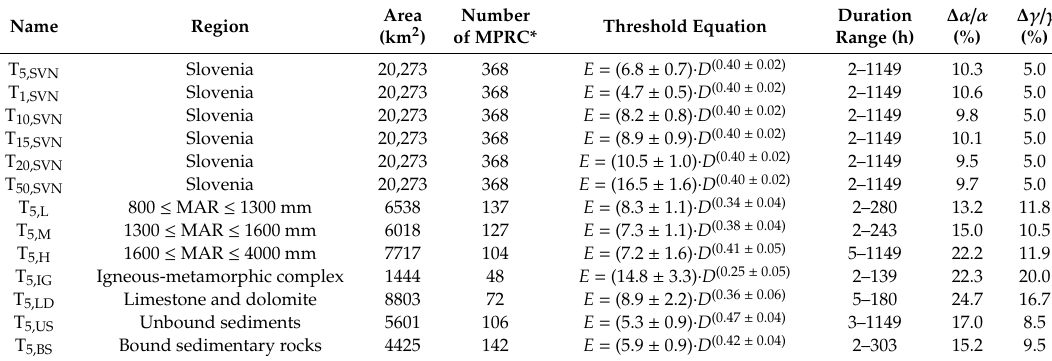
Table 1. Main characteristics of rainfall thresholds defined in this study.